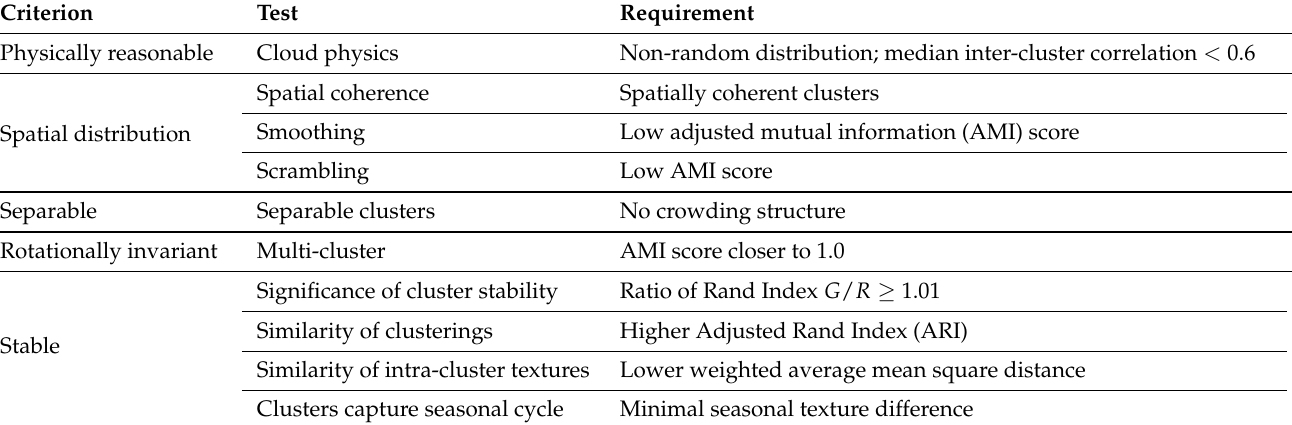
Table 4. Our five evaluation criteria protocol, as described in Kurihana et al. [18], and protocols for meeting them. In that work, we used the first four criteria to demonstrate that our quantitative and qualitative evaluation protocols can distinguish useful from non-useful autoencoders, even when common ML metrics such as (cid:96) 2 loss show insignificant differences. In the current work, we describe a protocol to ensure meeting the last criterion,